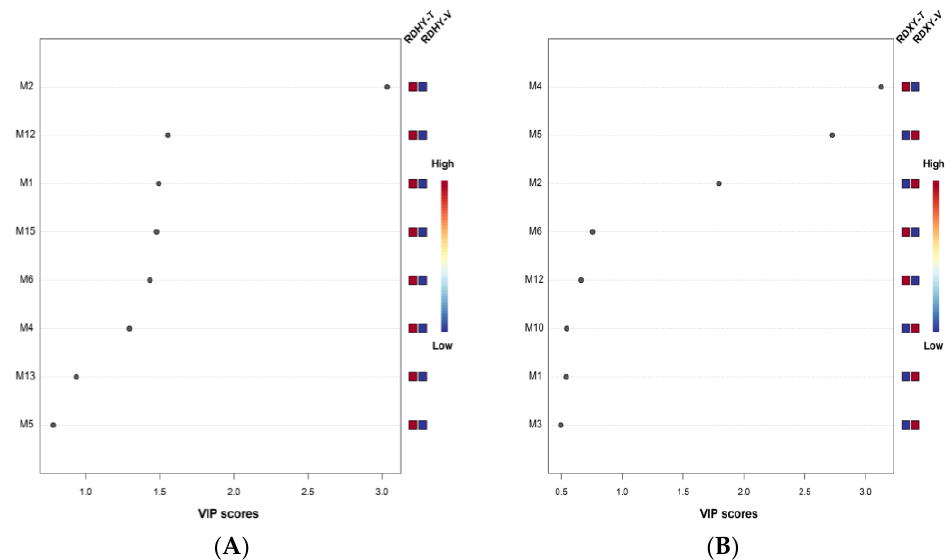
Figure 4. Main compounds based on variable importance in projection (VIP) values of RDHY ( A ) and RDXY ( B ). Note: RDHY, ‘RuiduHongyu’; RDXY, ‘RuiduXiangyu’; RG, ‘Red Globe’; T, the T trellis system; V, the V trellis system.